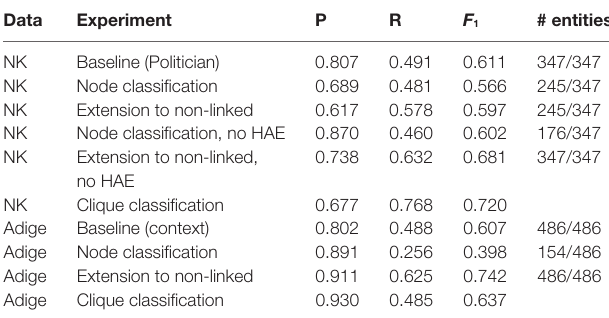
TaBle 2 | Evaluation of node and clique classification (HAE means “highly ambiguous